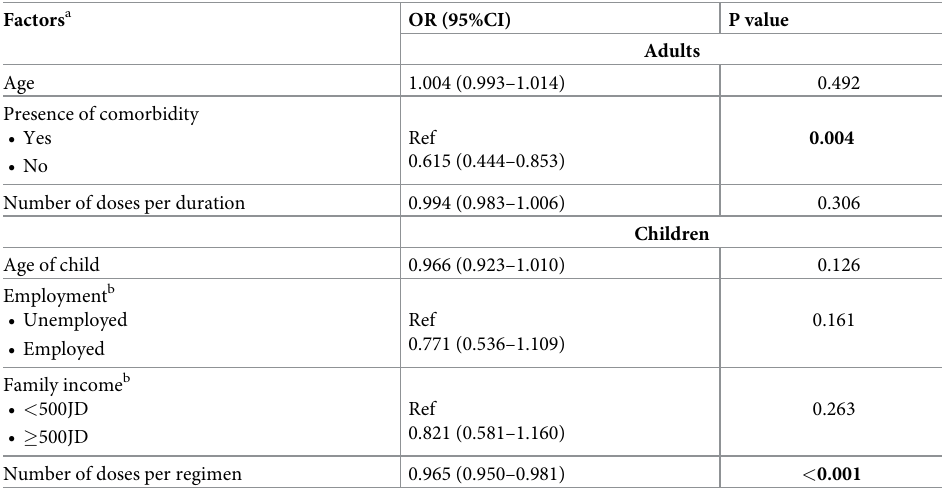
Table 3. Multivariate analysis of factors affecting short-term